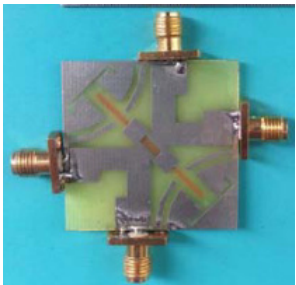
Figure 15. ACS-fed 4 port antenna [77].